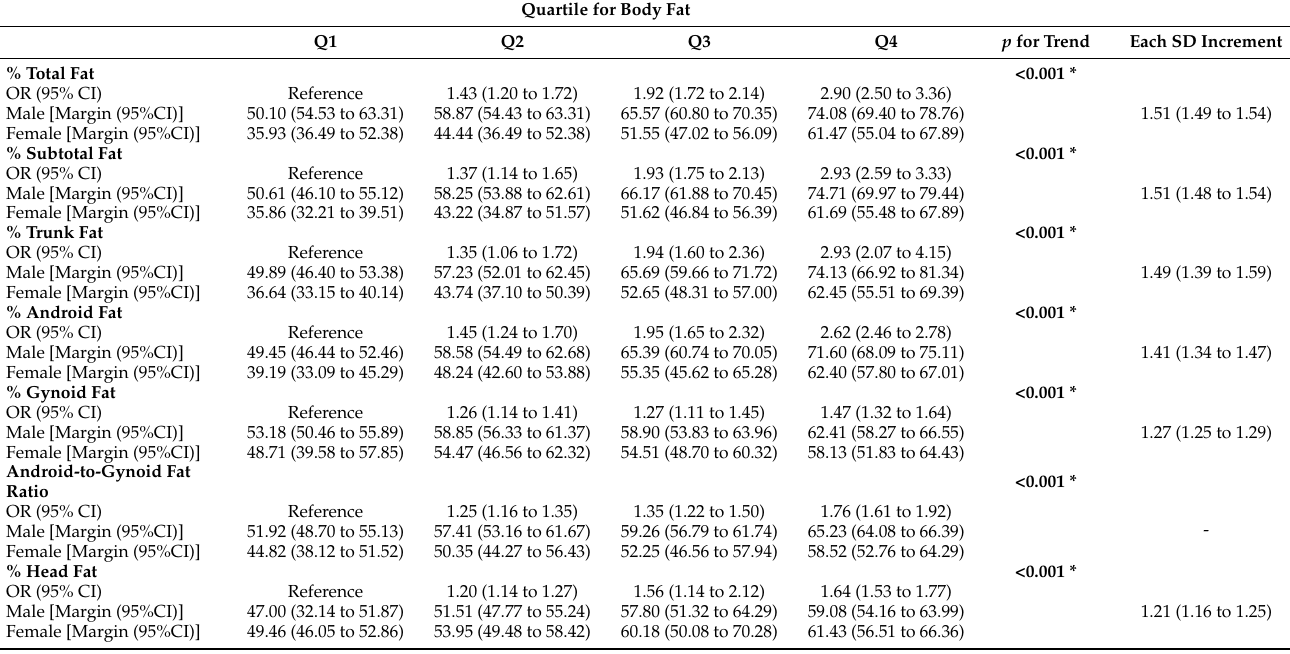
Table 5. Multivariate Analysis of Body Fat on Risk of NAFLD Development in Obese